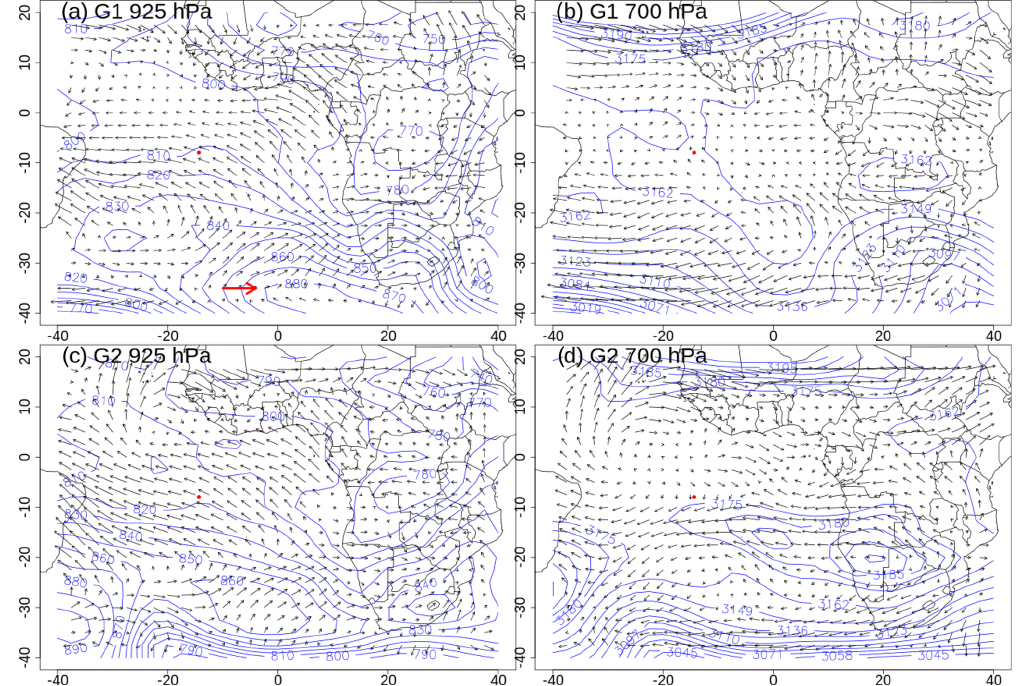
Figure 10. Mean geopotential height (m) of (a) group G1 at 925hPa, (b) group G1 at 700hPa, (c) group G2 at 925hPa, and (d) group G2 at 700hPa. The x axis and y axis are longitude and latitude in degrees, respectively. Ascension Island is marked as a red dot. Wind speed and direction vectors are plotted as arrows with a reference 20ms − 1 westerly wind vector plotted in red for reference in (a) .